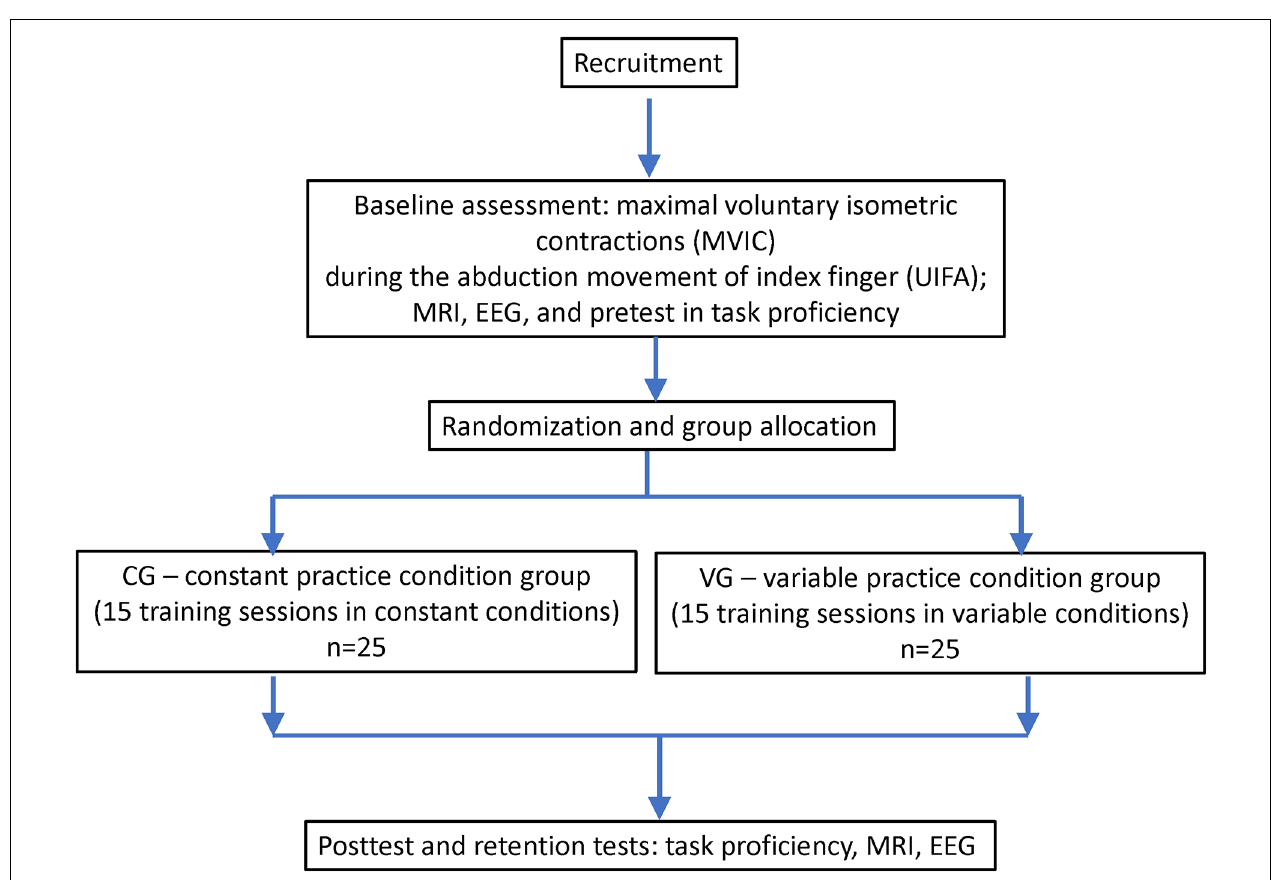
FIGURE 1 | Flowchart of the